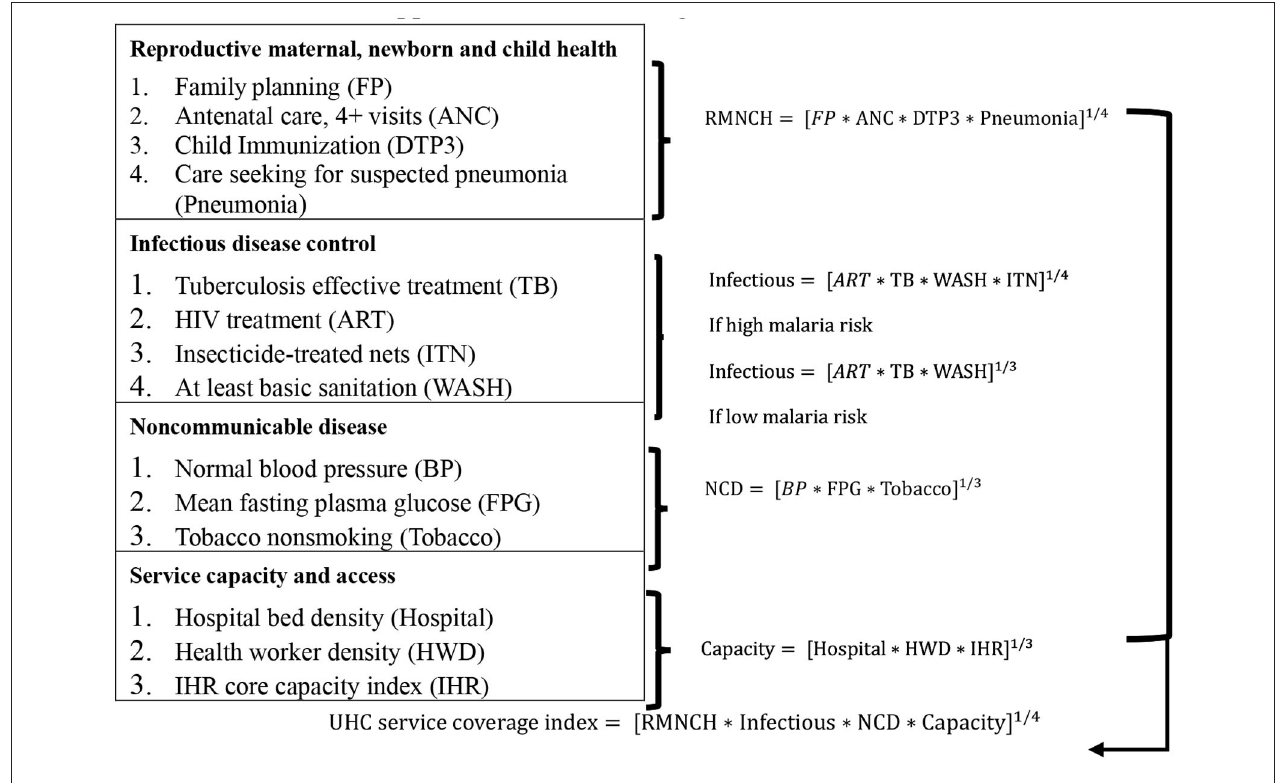
FIGURE 1 | UHC service coverage index (2) 2